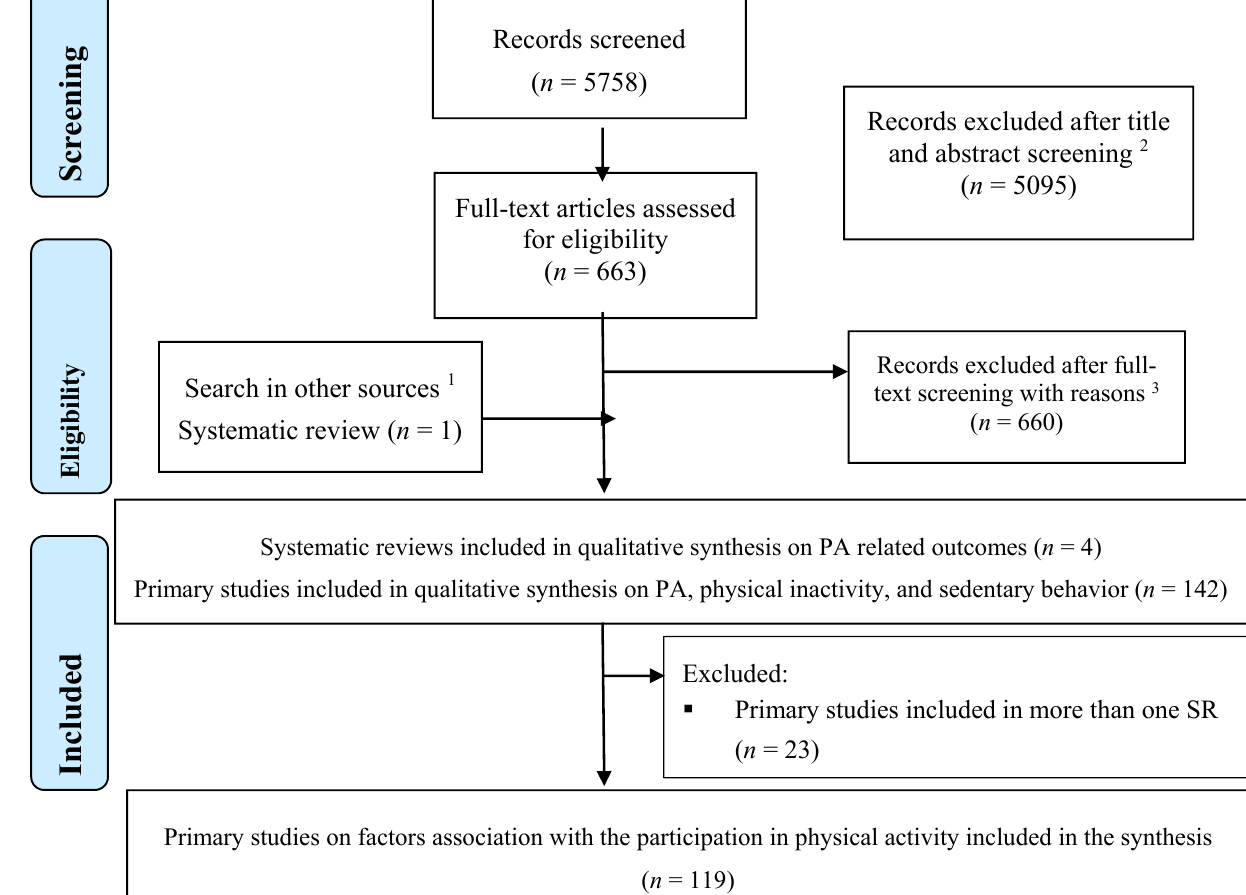
Figure 1. Preferred Reporting Items for Systematic Reviews and Meta-Analyses (PRISMA) 2009 flowchart of the systematic reviews inclusion. 1 Google Scholar and manual search of the references in the included studies. 2 Systematic reviews were excluded from the overview because they did not meet our inclusion criteria; 3 not a systematic review ( n = 116), no data on barriers to physical activity ( n = 507), not a population from MENA ( n = 34), duplicate ( n = 1), and publication in Portuguese ( n = 1), a systematic review with qualitative data only ( n = 1).